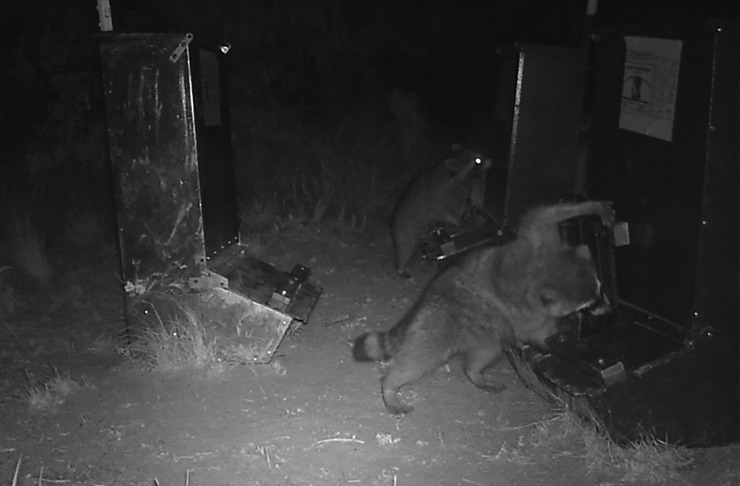
Raccoons opening commercial feeder doors with 4.5 kg weights attached.